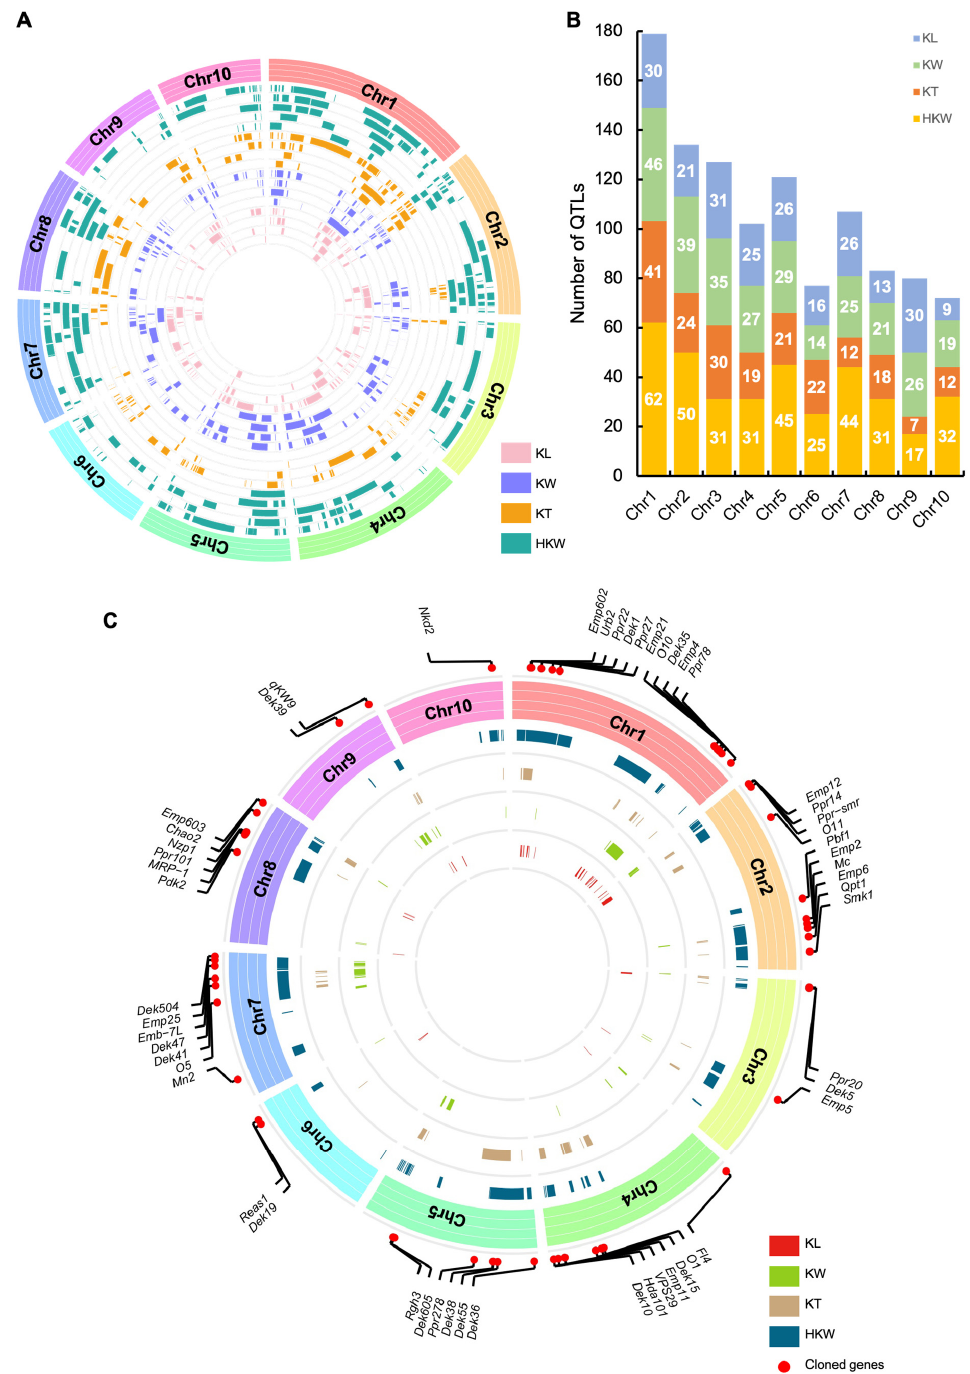
Figure 5. Graphic illustration of identified QTLs and QTL clusters of four maize kernel size-related traits. ( A ) Diagram of genomic distribution of original QTLs for four traits on ten maize chromo- somes. ( B ) The number and distribution of original QTLs for four traits on ten maize chromosomes. ( C ) Distribution of QTL clusters and known cloned genes. KL, kernel length; KW, kernel width; KT, kernel thickness; HKW, hundred-kernel weight; Chr,